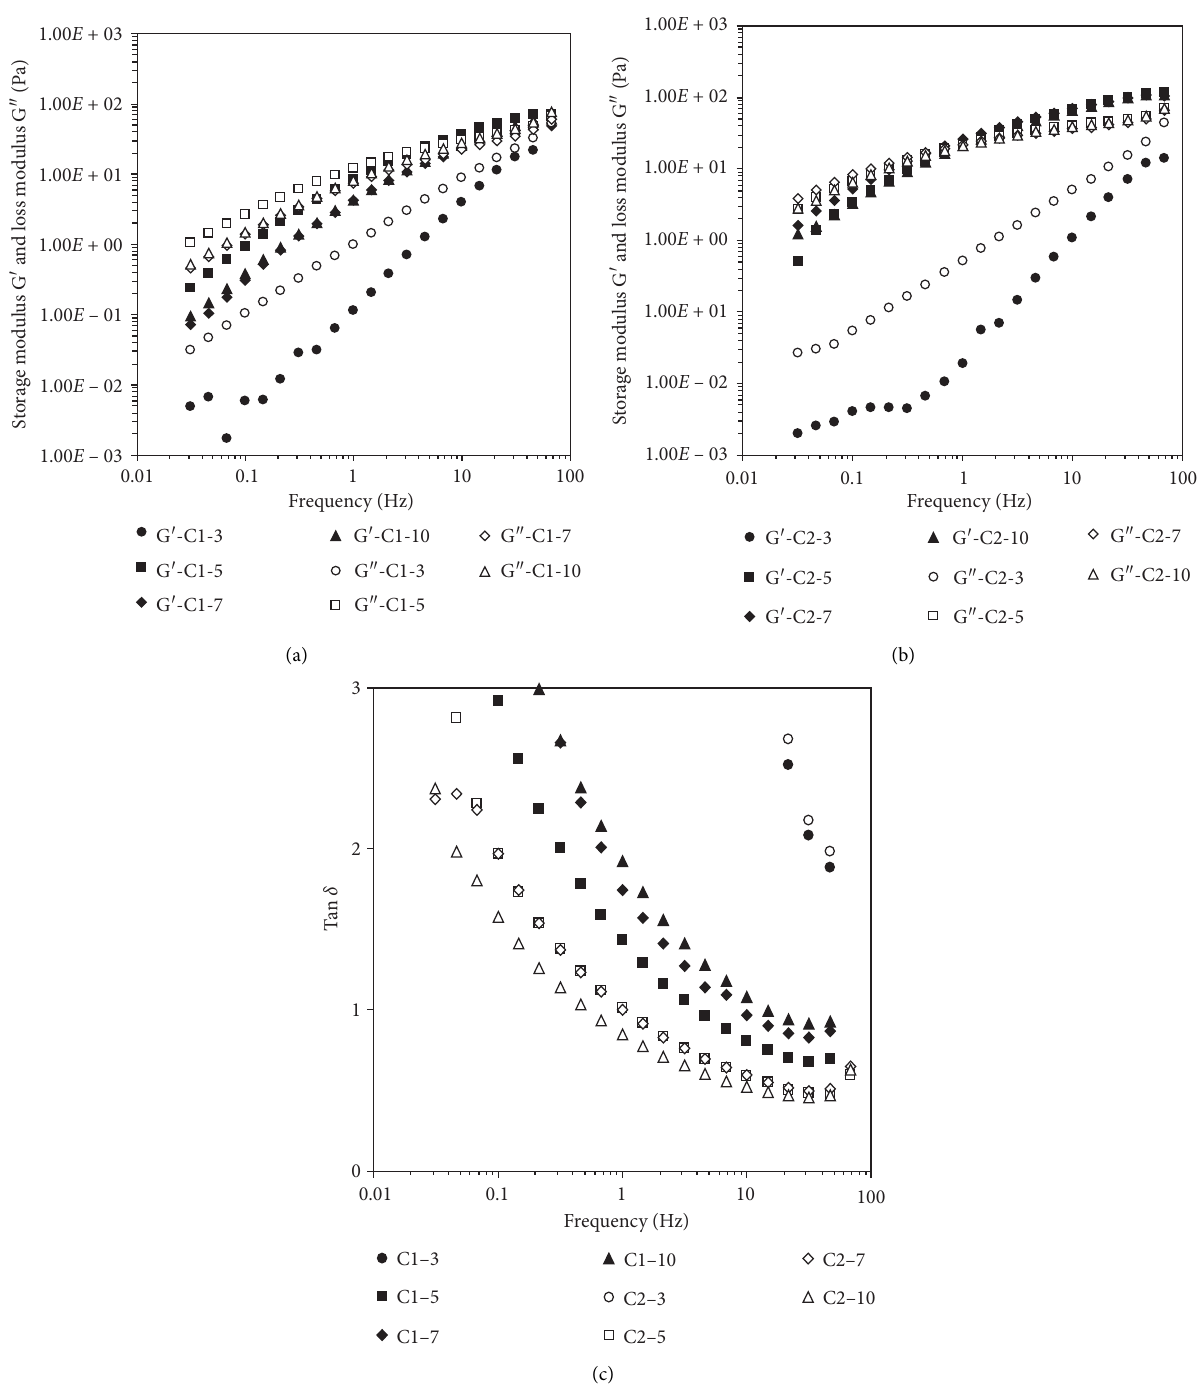
Figure 5: The viscoelasticity of chitin-DMAc solutions containing different LiCl concentrations for (a) C1 and (b) C2 and (c) tan δ as a function of Figure 6. Before measurements, the chitin samples were washed in excess amount of diluted water to remove traces of solvent. Here, the water content of the chitin hydrogel decreased with the increment in LiCl concentration, and the value was reduced from 461 to 388% for C1-3 and C1-10, respectively, as shown in Table 1. However, the lower value